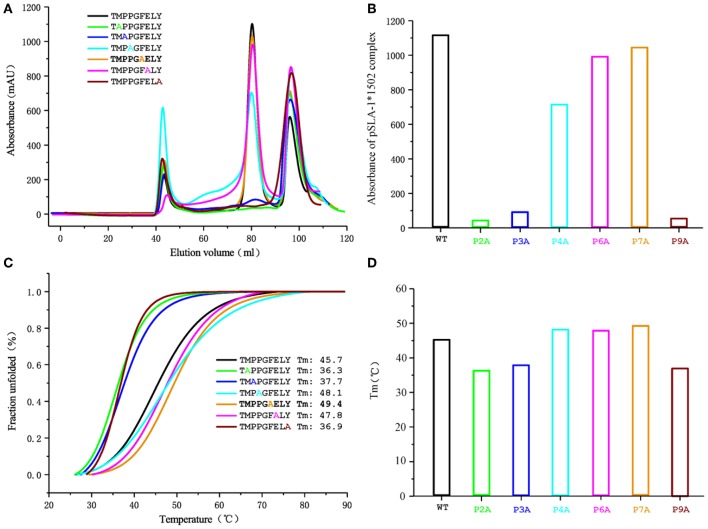
Gel filtration chromatogram and CD spectra of the NSP9-TMP9 peptide and its mutants. The elution curves and CD spectra of the complexes with different peptides are indicated in different colors. (A) Gel filtration chromatograms of the refolded products obtained with a Superdex 200 10/300 GL column (GE Healthcare). The aggregated H chain, the correctly refolded pSLA-1*1502 complex (~45 kDa), and excess β2m are indicated by three peaks appearing in order. The efficiency of refolding is represented by the height of the pSLA-1*1502 complex peak. A higher peak indicates better efficiency of the peptide in promoting the renaturation of SLA I. (B) Bar graph of the peak absorbance of the pSLA-1*1502 complex. Bars with different colors show the differences in the refolding efficiencies of the pSLA-1*1502 complex with alanine scanning peptides. (C) Thermostability of the pSLA-1*1502 complex with the NSP9-TMP9 peptide and the peptide harboring substitutions (alanine screening of NSP9-TMP9). CD spectra were utilized to assess the thermostability of purified pSLA-1*1502 complexes. Denaturation was monitored at 218 nm as the temperature was ramped up from 25 to 90°C at 1°C/min. The fitting data for the denaturation curves obtained using Origin 9.1 (OriginLab) are shown. The Tms of different peptides (when 50% of the fraction was unfolded) are indicated by the gray line. (D) Bar graph of the thermostability of the pSLA-1*1502 complex. Bars with different colors show the Tm values of the pSLA-1*1502 complex with alanine scanning peptides more clearly.